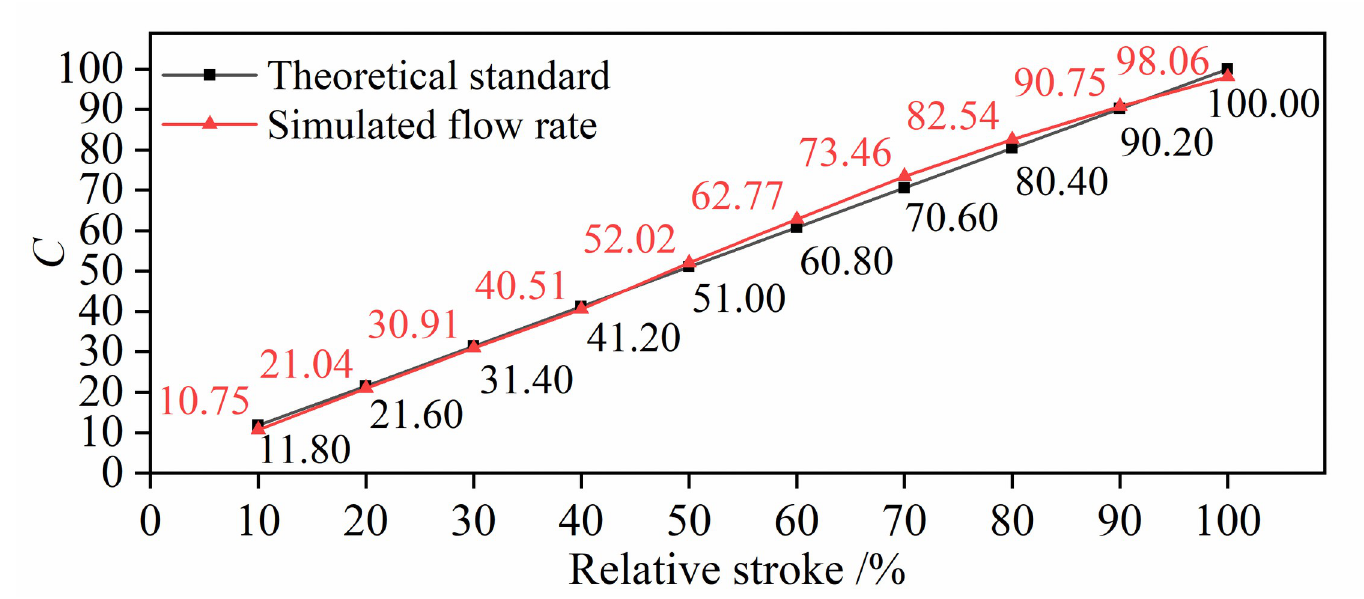
Fig 3. Comparison of simulated flow rate with standard